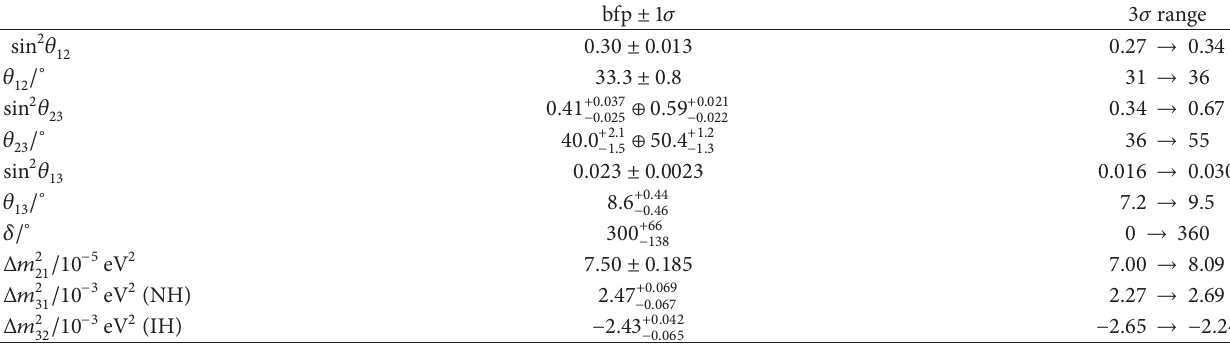
Table 1: Three-flavour oscillation parameters from a fit to global data after the Neutrino2012 conference [10]. The normalization of reactor neutrino fluxes is determined by short-baseline reactor data, which are included in the